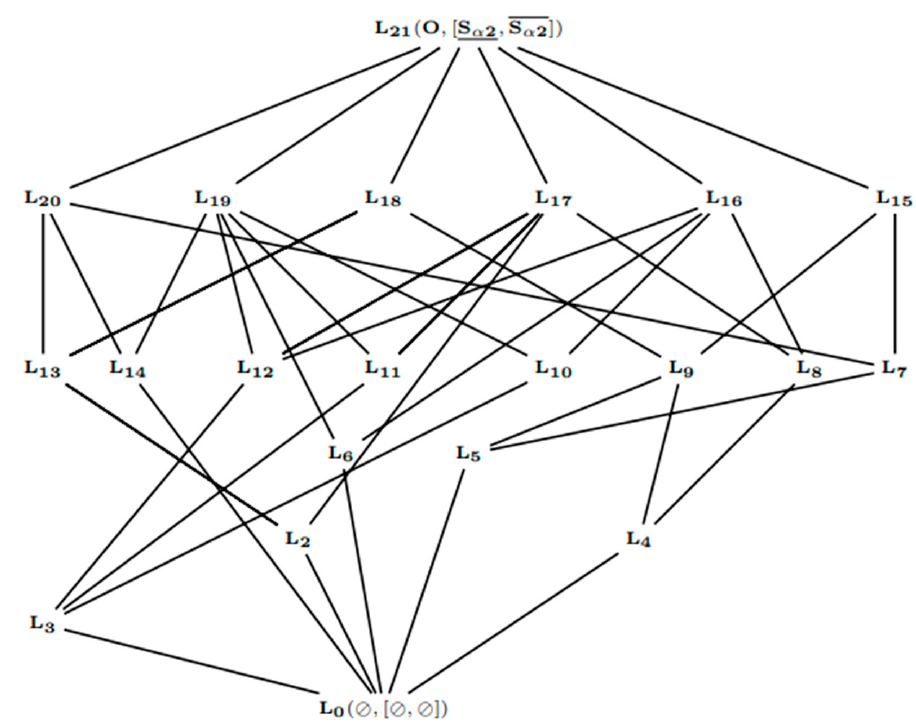
Figure 8. From Table S α 2 . Table 8. 𝑆 (cid:2871) .